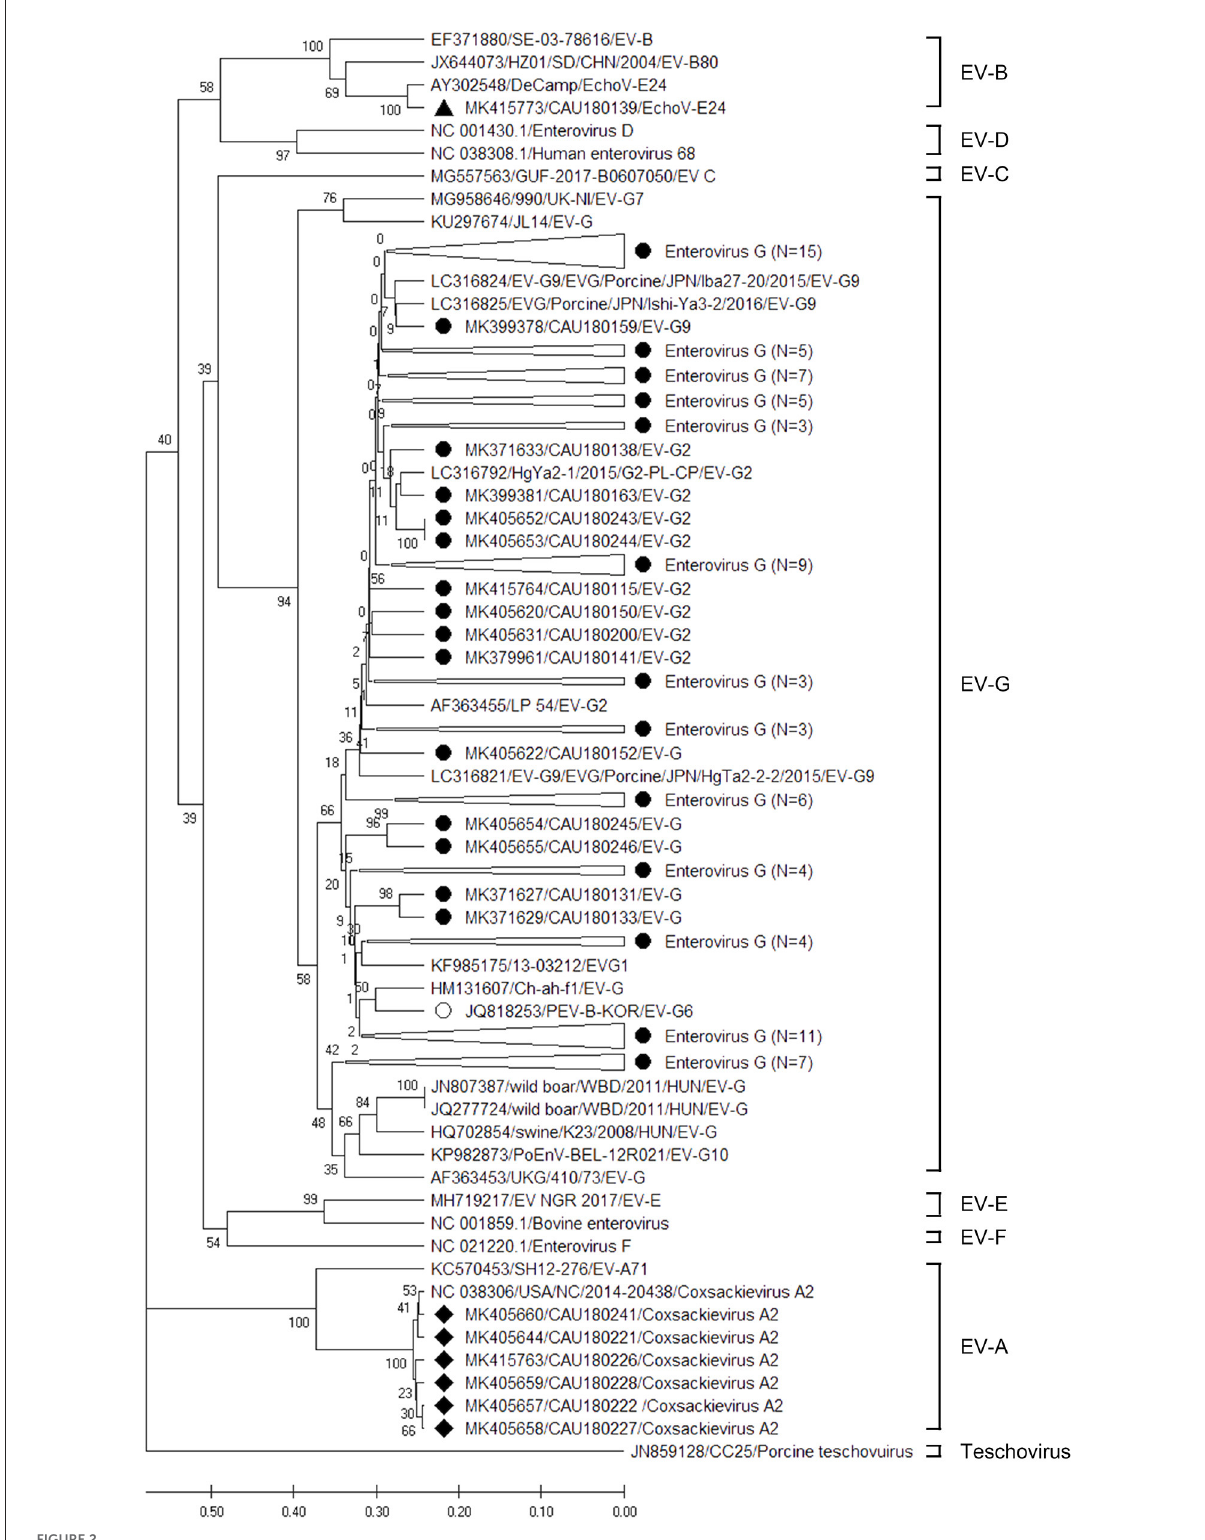
FIGURE2 Phylogenetic analysis of the EVs detected in porcine stools and swabs. The EV phylogenetic tree was constructed using the Unweighted Pair Group Method with Arithmetic Mean (UPGMA) and based on the 191-bp sequence of the RdRp region. The black circles (•), black squares ( (cid:4)